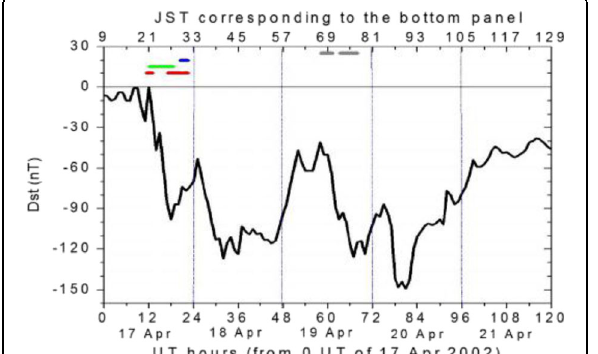
Fig. 5 Dst variation and occurrence of spread-F during a multiple geomagnetic storm with first main phase on 17 April 2002. Spread-F occurrences are indicated by thick horizontal lines (red for Okinawa, green for Yamagawa, blue for Kokubunji and grey for Wakkanai) high solar activity (Fig. 2) occurred during the middle of the long storm (Fig. 5) with no spread-F at lower latitudes. The strong spread-F started at ~ 19.5 LT and lasted for over 9 h which could most probably be due to storm- related MSTIDs originated at high latitudes.